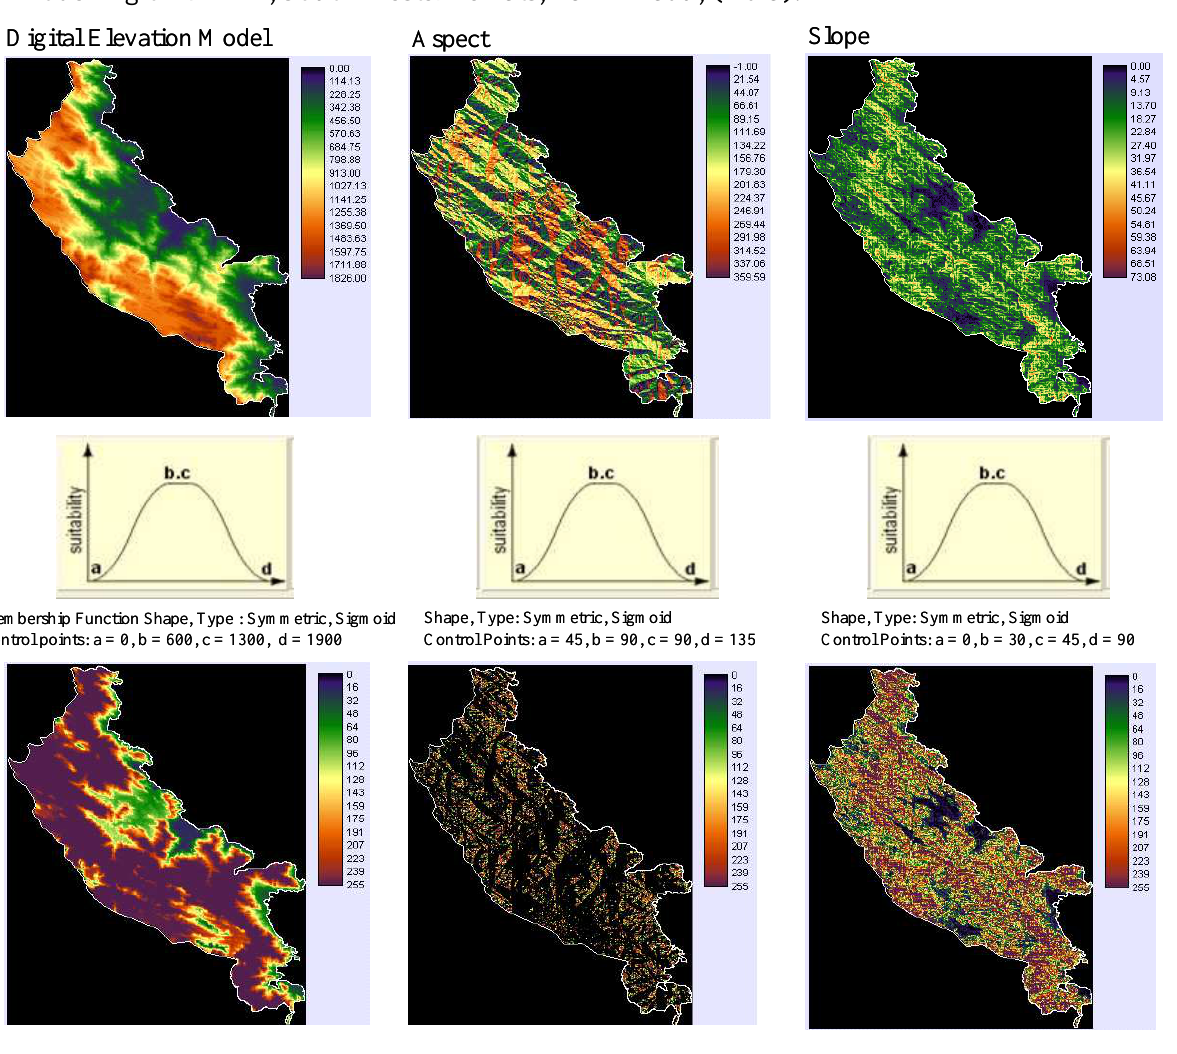
Figure 5. (a) List of potential spatial drivers (DEM, aspect, slope) prepared using multi- criteria decision support to generate suitability image for the evergreen forest change modelling of KMTR, South Western Ghats, Tamil Nadu,